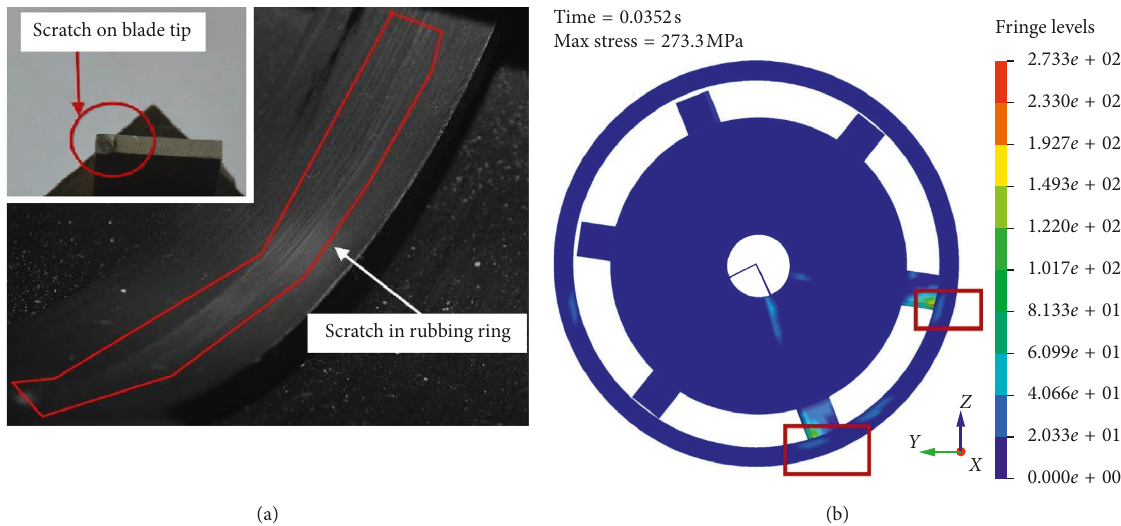
Figure 11: Results of heavy rub-impact condition. (a) Scratch on rubbing ring and blade. (b) Von Mises stress